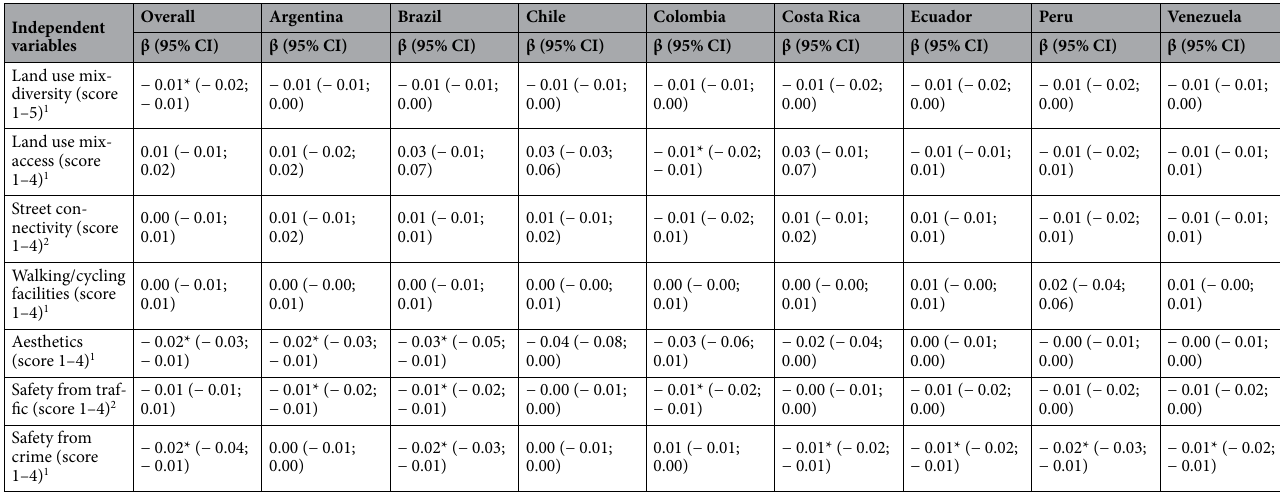
Table 6. Linear regression models (unstandardized β, 95% CI) for perceived urban environment attributes and waist-to-height ratio. Linear regression models adjusted for age, sex, marital status, work status, socioeconomic level, and energy intake. *indicates statistically significant associations (p < 0.05). CI confidence interval. 1 Higher scores indicate perception of higher land use mix-diversity, higher land use mix-access, more walking/cycling facilities, better aesthetics, and more safety from crime. 2 4-point scale: strongly disagree (1), disagree (2), agree (3), strongly agree